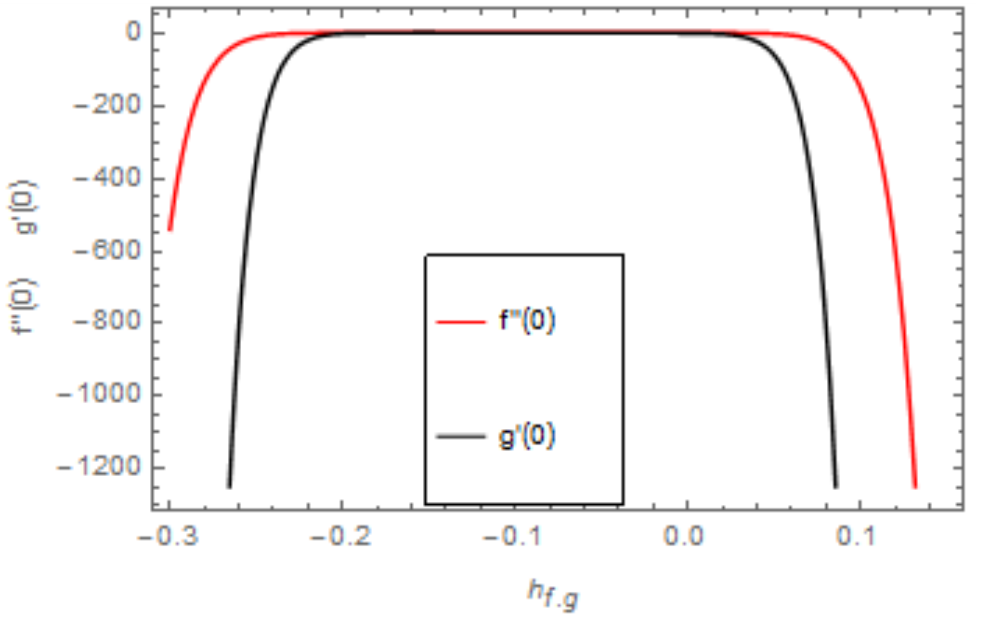
Molecules 2020 , 25 , x FOR PEER REVIEW 8 of 21 Figure 2. Curves for velocities profiles f (cid:48)(cid:48) ( 0 ) and g (cid:48) ( 0 ) . Figure 2. Curves for velocities profiles